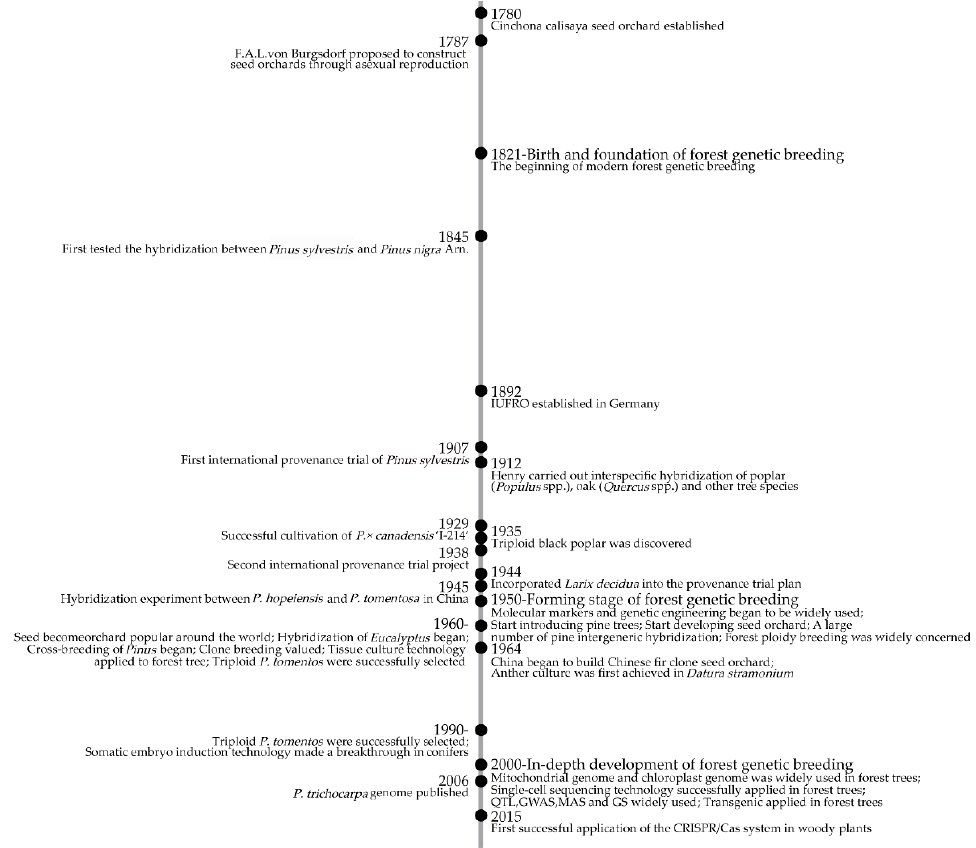
Figure 1. Development stages of forest genetic breeding: birth and foundation stage (1821 – 1950), formation stage (1950 – 2000), and further development stage (2000 – present).